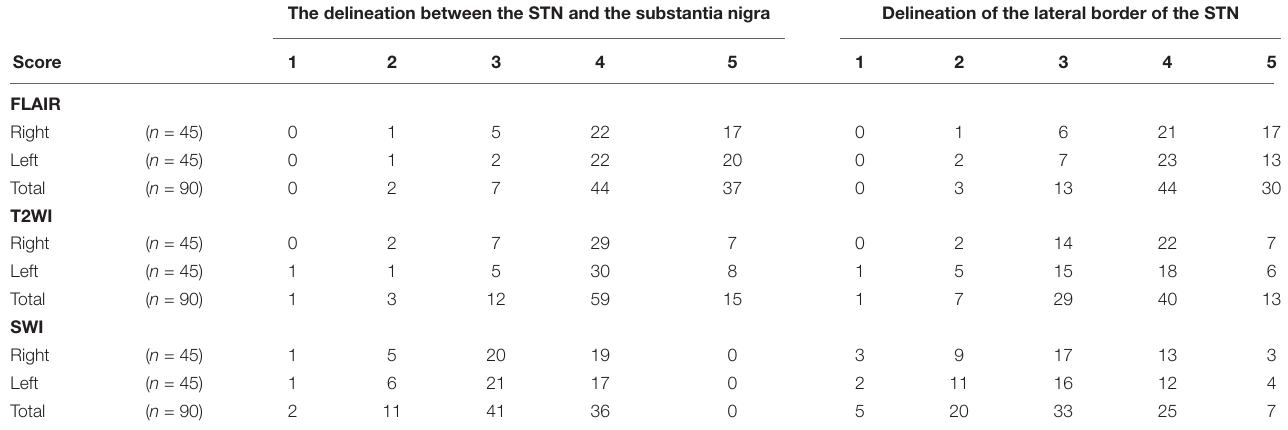
TABLE 5 | Results of the fixed-points scale scores for delineation between the STN and the substantia nigra, and the scoring for the lateral border of the STN. The delineation between the STN and the substantia nigra Delineation of the lateral border of the